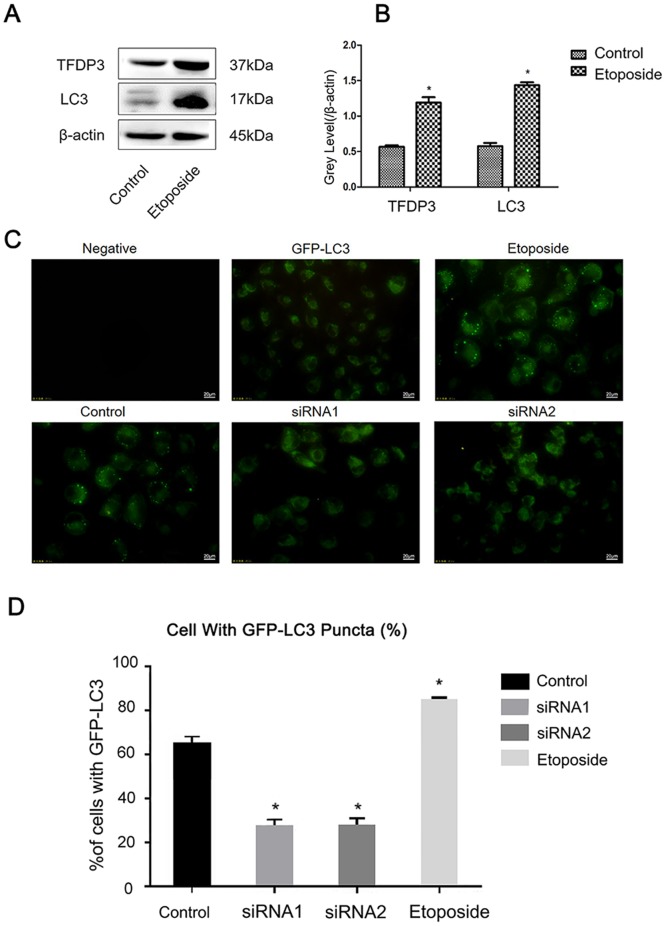
Etoposide on inducing autophagy of breast cancer cell line MDA-MB-231 and the autophagy process after siRNA knocks down TFDP3 expression.A, Expression levels of TFDP3 and LC3 in MDA-MB-231 with or without treatment of etoposide for 24 hours using Western Blot; B, Gray scale statistics for fig 4A. The experiment was repeated for three times and the gray scale of Western Blot stripes was analyzed using Image-Pro Plus software; Then an independent sample T-test was applied to analyze the relative gray values between the GFP-LC3 control group and 1μM etoposide treatment group. For the analysis, the relative gray values (TFDP3/β-actin, LC3/β-actin) were calculated; C, Autophagosomes in all groups, and the green fluorescence of GFP-LC3 were evaluated using fluorescence microscopy (n = 3); D, Percentage of the GFP-LC3 positive cells which exhibited punctate GFP-LC3 fluorescence; All groups were evaluated; cells with >2 autophagosomes per cell were declared as exhibiting an autophagic reaction. An independent sample t-test was used to analyze the number of autophagosomes in the control group, which was significantly higher than the siRNA1 group (p<0.05).